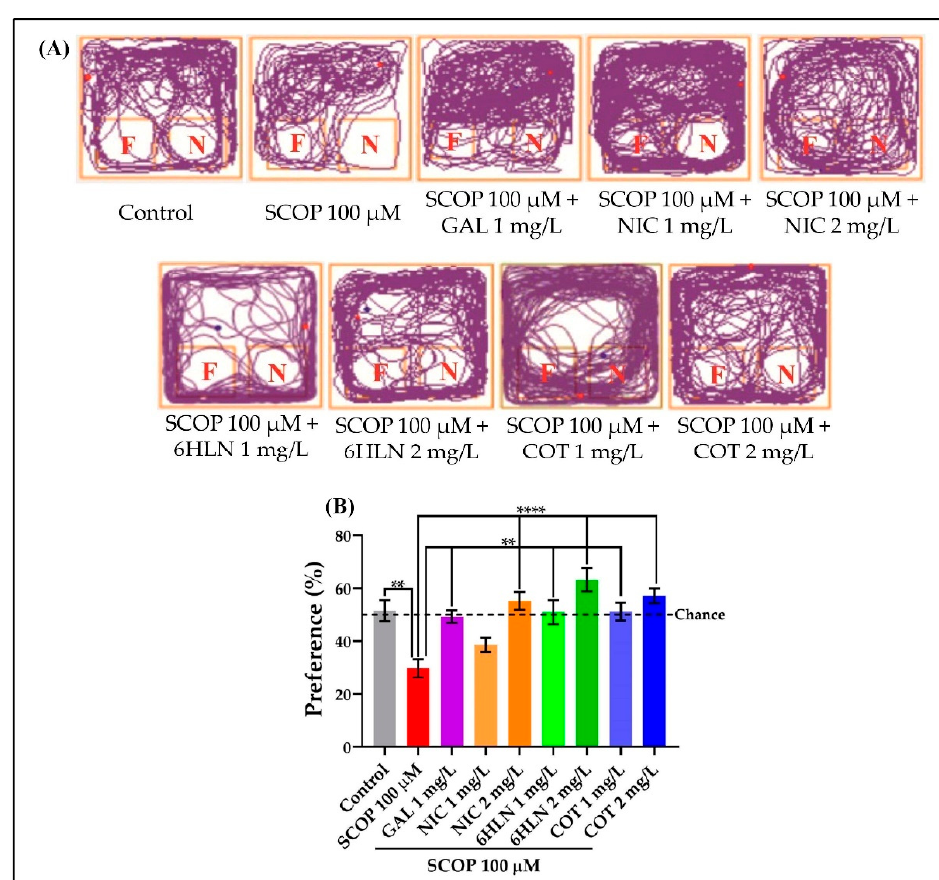
Figure 5. The effects of nicotine (NIC), 6 ‐ hydroxy ‐ L ‐ nicotine (6HLN), and cotinine (COT) (1 and 2 mg/L) administration in scopolamine (SCOP) ‐ treated zebrafish on recognition memory evaluated within object discrimination task. ( A ) The locomotor tracking pattern of the zebrafish within the testing session of the object discrimination task according to the groups they belong to. The blue dot represents the beginning of the route, while the red dot represents the end of the route. The prefer ‐ ence percentage ( B ) was considered the endpoint for recognition memory. The familiar and the novel objects were noted with F and N, respectively. The black dashed line (chance) indicates a 50% preference. The values are expressed as means ± S.E.M. ( n = 10). ANOVA analysis revealed overall significant differences between groups for ( B ) F(8,81) = 8.078, p < 0.0001. For Tukey posthoc anal ‐ yses—**** p < 0.0001, and ** p < 0.001.